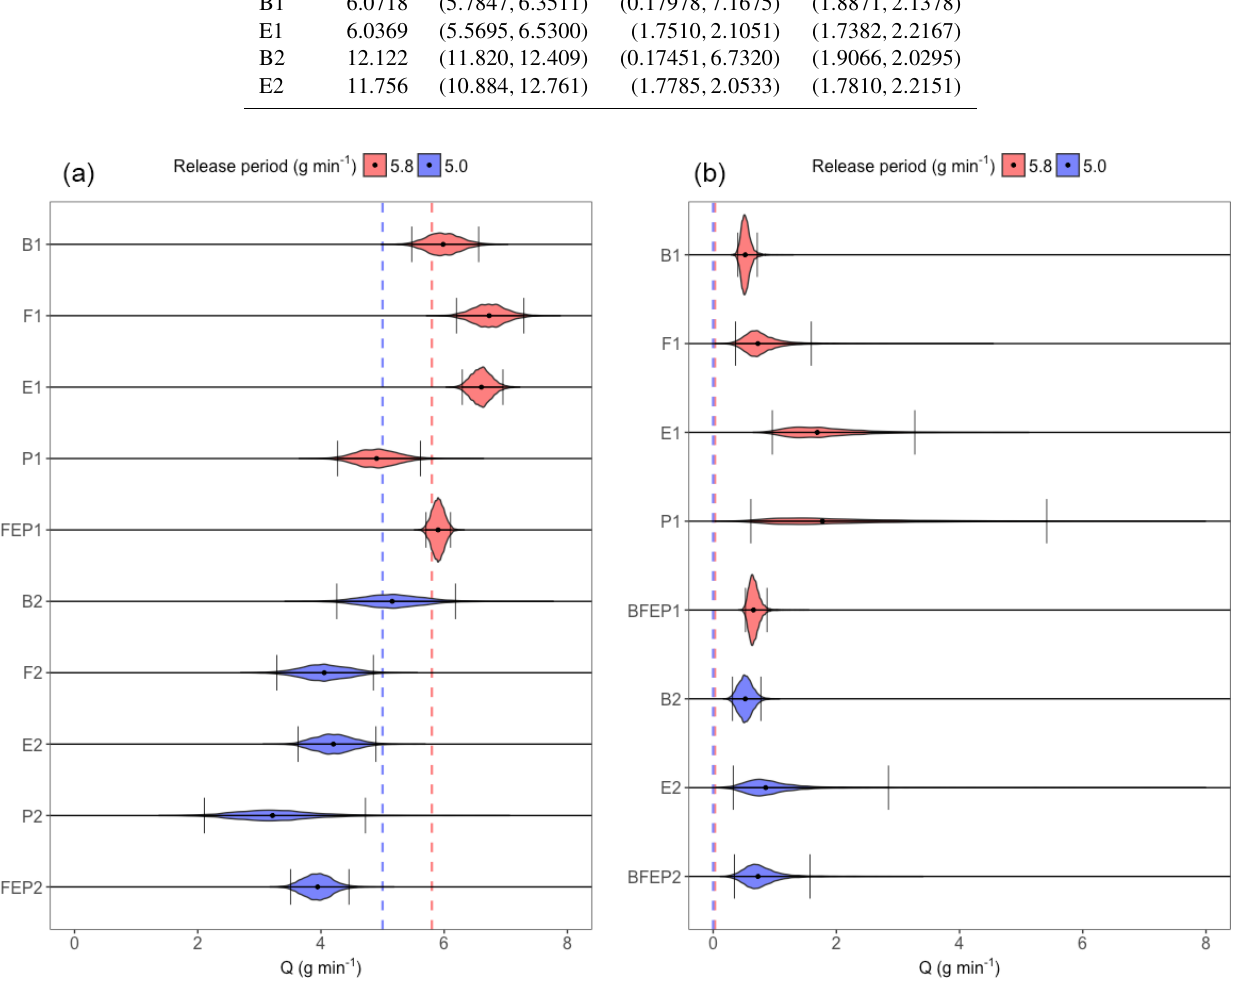
Figure 5. (a) Posterior empirical distributions of the emission rate Q in grams per minute (gmin − 1 ), for the Boreal lasers (B), FTIR spectrometers (F), EC towers (E), Picarro analysers (P), and the ensemble of all instruments (BFEP), for each release-rate period (1 and 2) during the Ginninderra experiment. The 5.8gmin − 1 release-rate period is shown in red (B1, F1, E1, P1, and BFEP1), while the 5.0gmin − 1 release-rate period is shown in blue (B2, F2, E2, P2, and BFEP2). The vertical dashed lines denote the respective true emission rates, the black dots denote the median estimates, and the black vertical bars denote the upper and lower limits of the 95% posterior credible intervals. (b) Same as (a) but showing results obtained using measurements taken when the methane point source was inactive. In both cases, we can recover a reasonable range of estimates for the emission rate, with no 95% posterior credible interval being far from the true emission rate. Further, we see that the posterior emission rate credible intervals move towards zero when the source is inactive, as